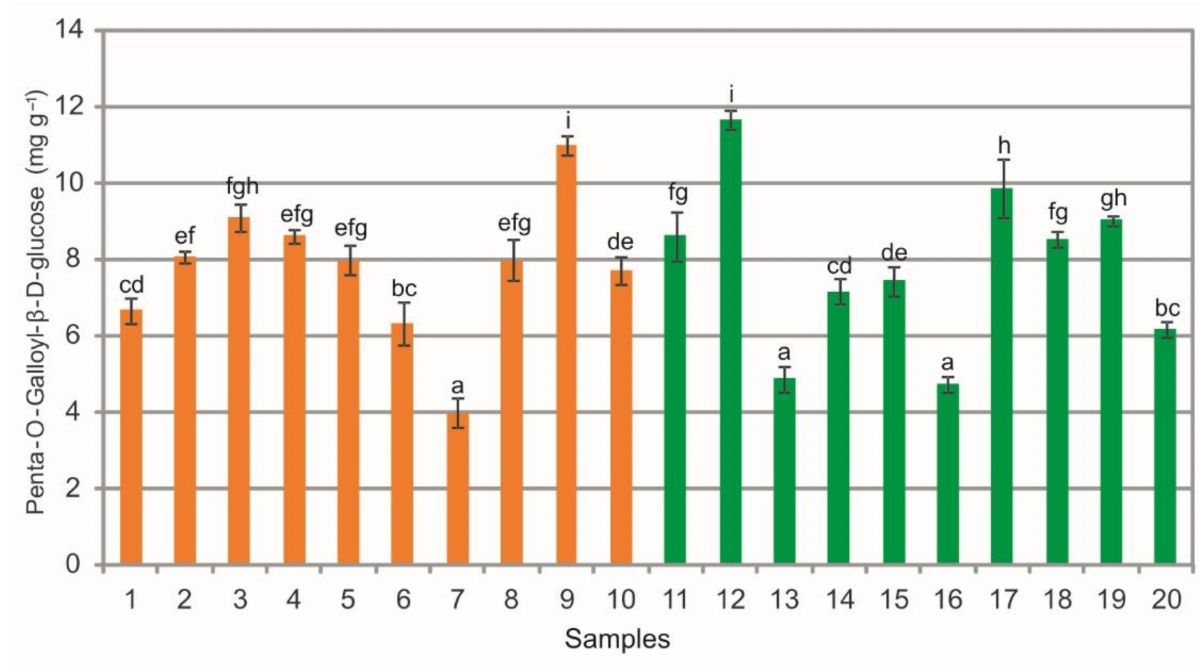
Figure 5. Penta-O-galloyl- β - D -glucose contents (mg g − 1 ) in leaf extracts from bearberry plants collected in heathland populations (orange) and in pine forest populations (green). For each site, data are mean and SD. The values designated by the different letters are significantly different (Tukey test, p <